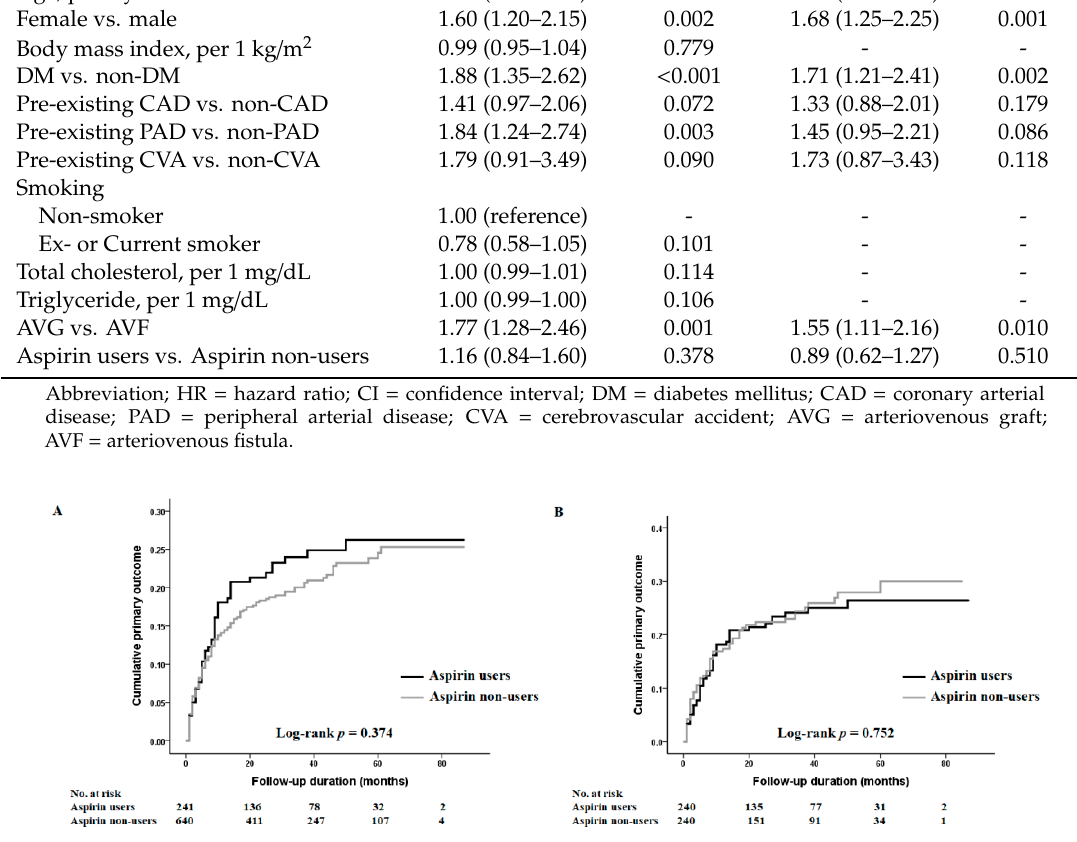
Figure 2. Kaplan-Meier plots for cumulative primary outcome; ( A ) overall subjects ( B ) propensity-matched cohort. There was no significant association between aspirin usage and protection against primary vascular access failure.